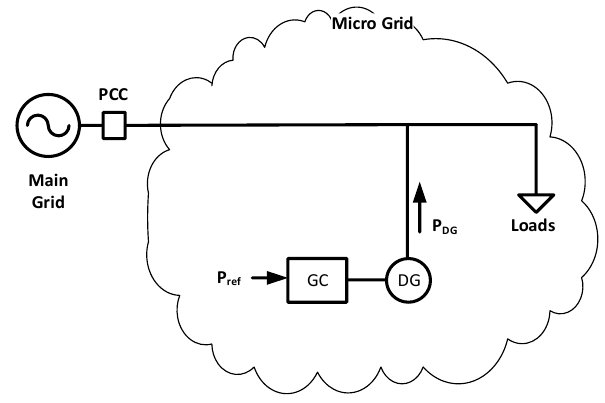
Figure 1. UPC mode of